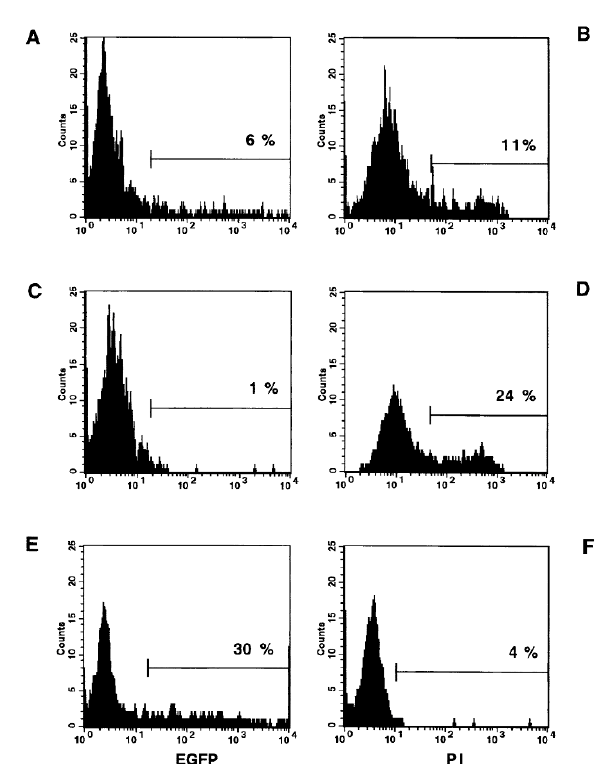
Figure 2 Representative results of flow cytometric analysis of transfected rat hepatic stellate cells and rat myofi- broblasts in comparison to NIH/3T3 cells using FuGENE™6 vehicle. For this experiment rHSCs, rMFBs and NIH/3T3 cells were transfected 2 days after seeding with 2 µ g reporter plasmid complexed with 5 µ l FuGENE™6. FACS analysis was performed 48 hours after transfection. Cultured cells were trypsinized under standard conditions and flow cytometric measurements were performed immedi- ately after collection of cells. Fluorescence signals were recorded with a flow cytometer FACS-Calibur (Becton Dick- inson, Sparks, MD) using a 488 nm excitation and a 530 ± 30 nm emission fluorescence filter for enhanced green fluores- cence protein (EGFP) and a 630 ± 11 nm emission fluores- cence filter for propidium iodide (PI), respectively. Data were acquired and analyzed with the CellQuest™ software ver- sion 3.1 (Becton Dickinson). Histograms of fluorescence intensities in EGFP (A, C, E) and PI (B, D, F) channels are shown for rHSC (A, B) , rMFB (C, D) and reporter cell line NIH/3T3 (E, F) , respectively. To establish background for fluorescence and to set gates for data acquisition, mock- transfected cells (not shown) were used. Mean fluorescence intensity was used to calculate levels of EGFP expression. Cells that took up PI were deemed nonviable. Nontrans- fected cells did not show fluorescence in EGFP